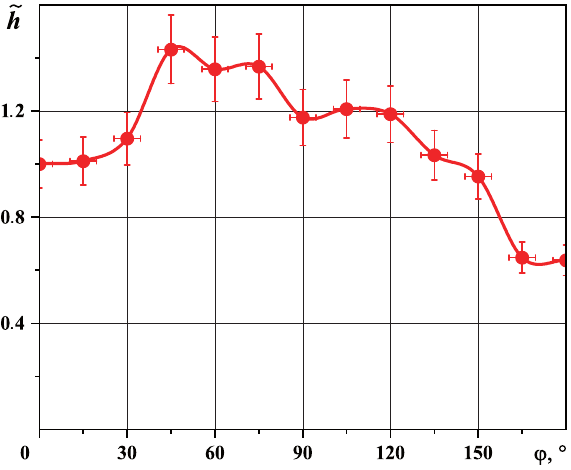
Figure 11. The relative HTC distribution over the horizontal pipe surface. Comparison of experimental and calculation results is ambiguous: 1. The experiment result indicates that the HTC maximum corresponds to the region of ϕ = 30. . .75 ◦ . 2. The HTC becomes less than the value on the upper generatrix only in the lower pipe region in the range of ϕ = 150. . .180 ◦ . 3. Theoretically, the HTC is equal to zero on the lower pipe generatrix. However, in practice this is not possible because then the thickness of the condensate film is equal to an infinitely large value. The experiment results indicate HTCs decrease in the lower pipe region which is associated with a sub-bottom zone